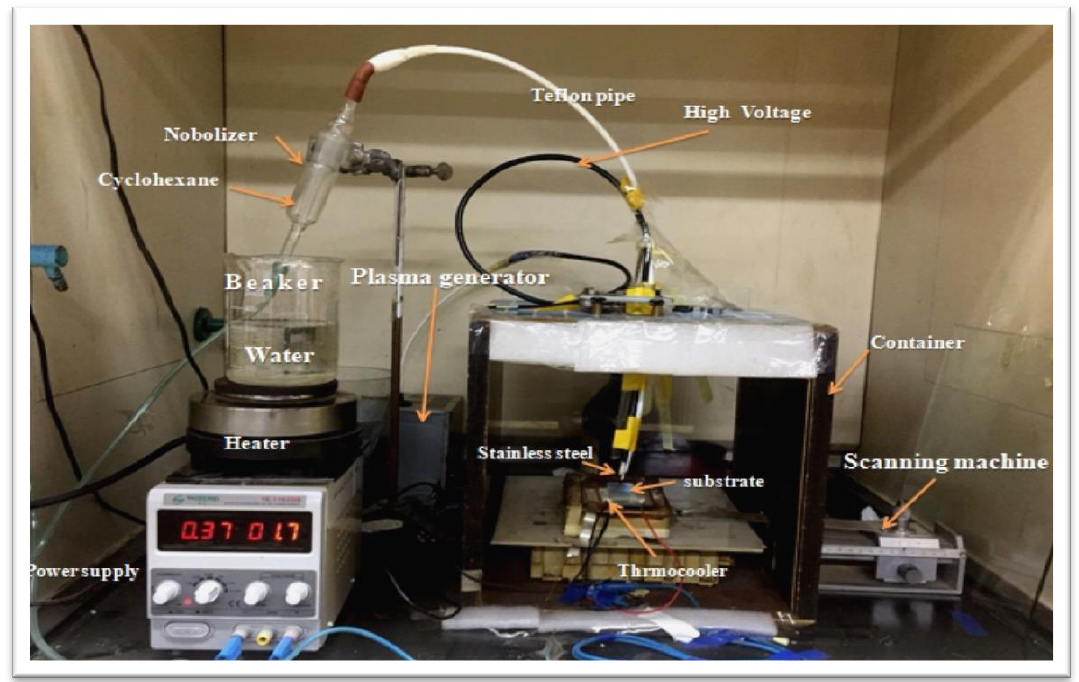
Fig. 1: The plasma jet system used to synthesize the DLC thin